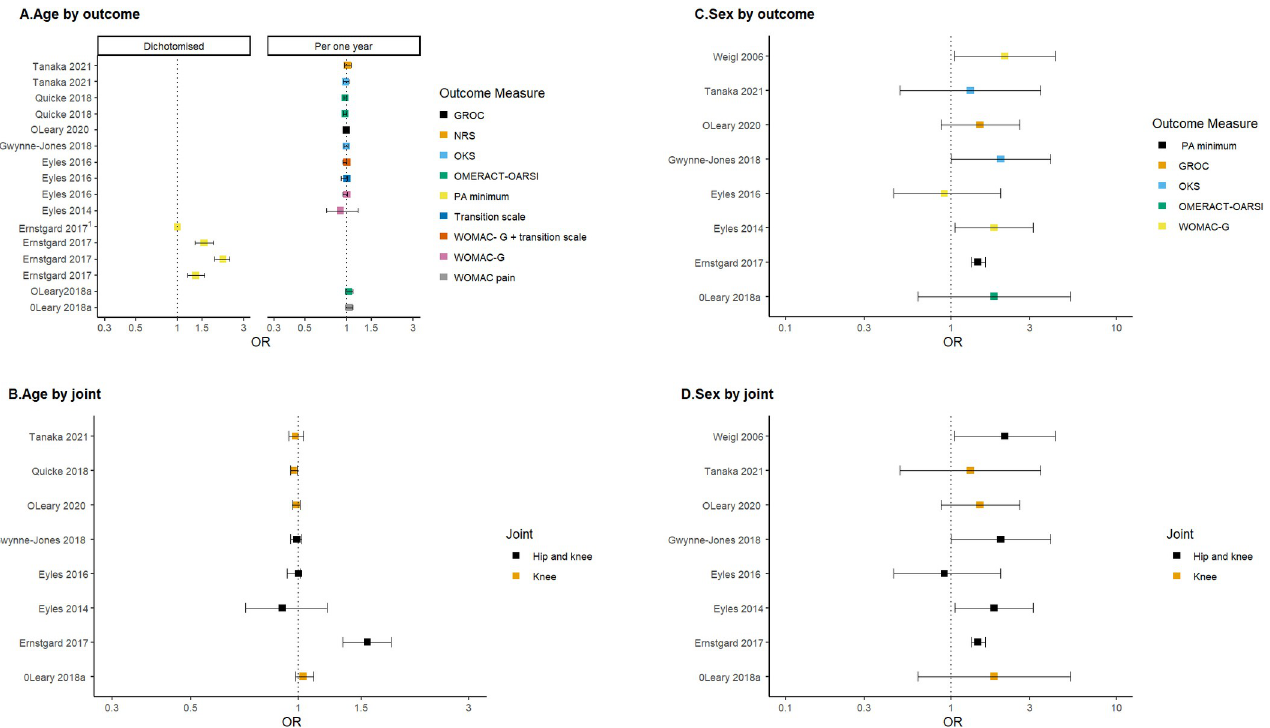
Fig 3. Effect of increasing age and female sex on the odds of positive response following a combined first-line intervention for knee osteoarthritis. All graphs report the log odds ratio and 95% CI. Repeated study labels by the same author represent multiple responder definitions within each study. The OR for sex reports the probability of a female (compared to a male) being a responder. OR > 1 = increased probability of female being a responder compared to a male. OR > 1 for age interpreted as increased probability of being a responder with increasing age. For age, original data from 8 studies reporting OR (7 cohorts, one secondary analysis of RCT). Studies not included: 2 reporting regression coefficients [25, 42] and 3 MD [15, 16, 37] and 1 HR [36]. For sex, original data from 8 cohort studies reporting OR. Studies not included: 3 reporting MD [15, 16, 37] and 1 HR [36]. 1. Ernstgard 2017 is grouped by ages and represents the OR of 75– 100 years, 65–74 years, 55–64 years compared to 22–54 years